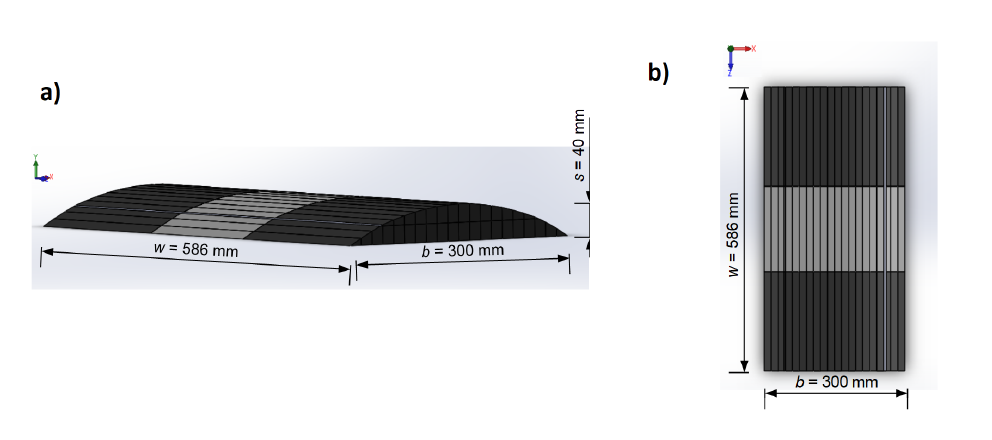
Figure 5. ( a ) ML3 landslide model geometry and dimensions. ( b ) Top view of ML3. Light grey slices are made of solid stainless steel machined bars. Black slices are made of aluminium machined